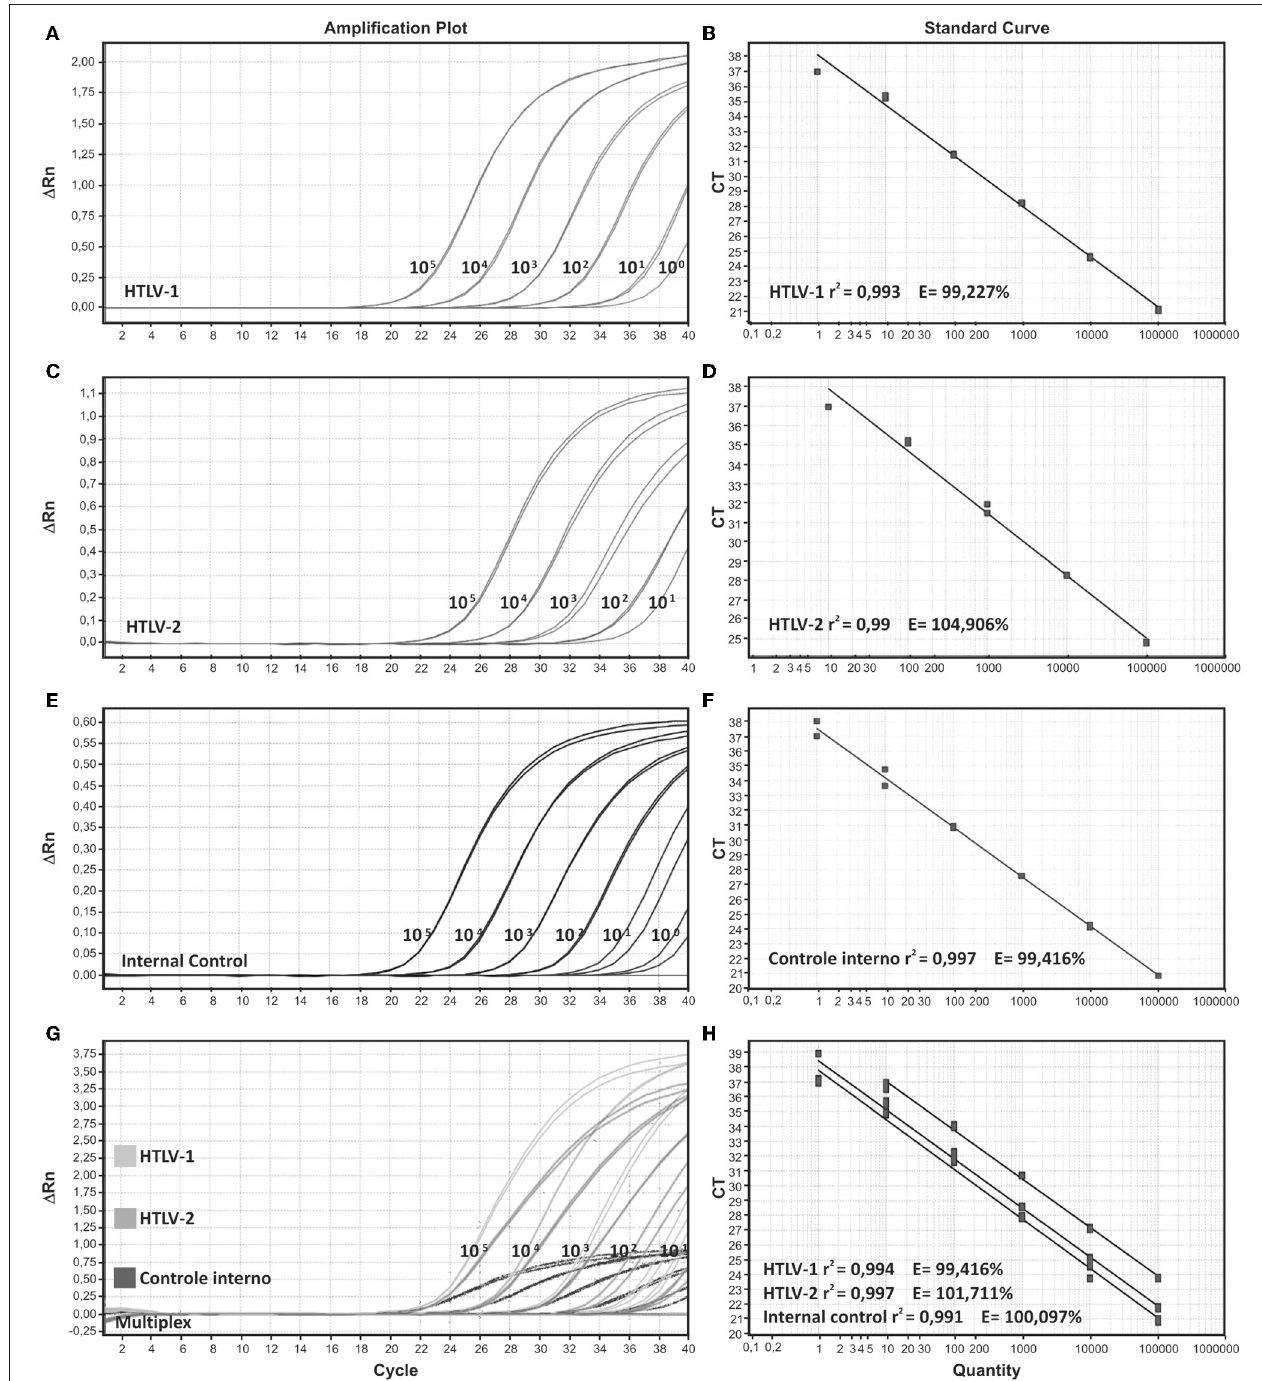
FIGURE 1 | Amplification plots and standard curves of singleplex and multiplex assays. Singleplex format is demonstrated for (A,B) HTLV-1, (C,D) HTLV-2, and (E,F) internal control, beta-globin. (G,H) Multiplex format for the three targets HTLV-1, HTLV-2, and beta globin. Serial decimal dilutions ranging from 105 to 100 copies/reaction were used in the qPCR reactions. DNA from MT-2 and Gu cell lines were used as positive samples for HTLV-1 and HTLV-2,